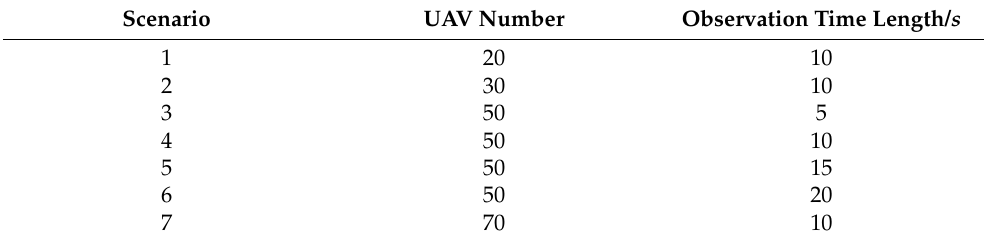
Table 5. Results of link prediction.